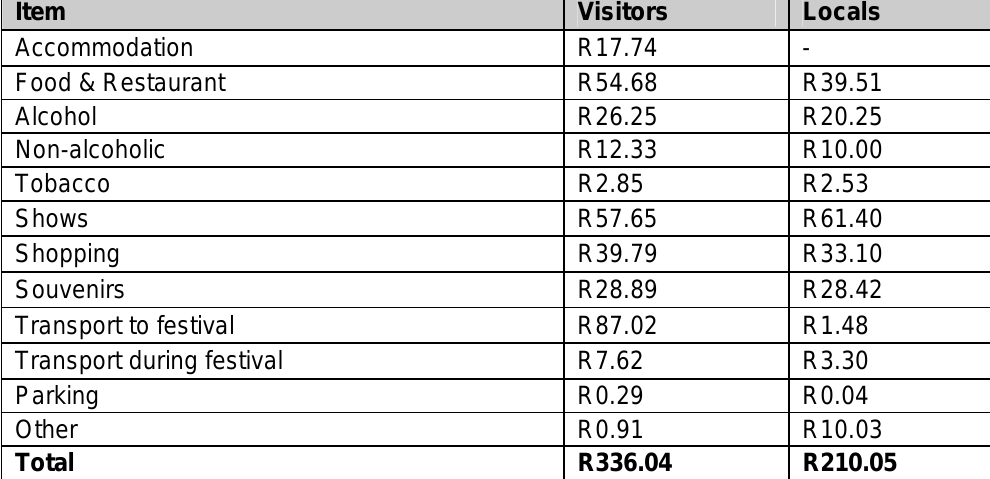
Table 3: Spending by festinos (per festino) Item